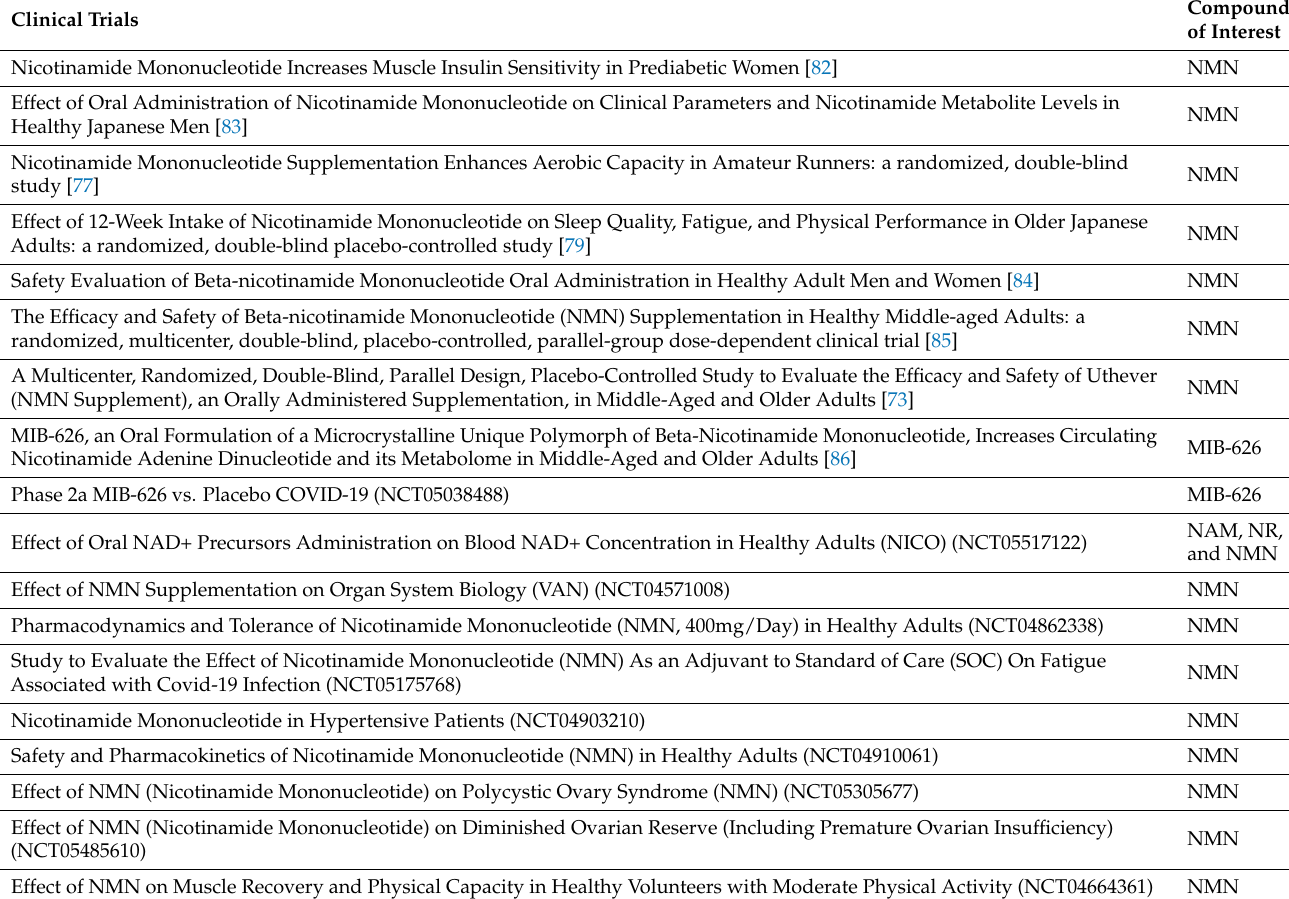
Table 1. Various clinical trials (completed and ongoing) detailing the use of NMN and other NMN derivates to improve health, metabolic markers, and disease